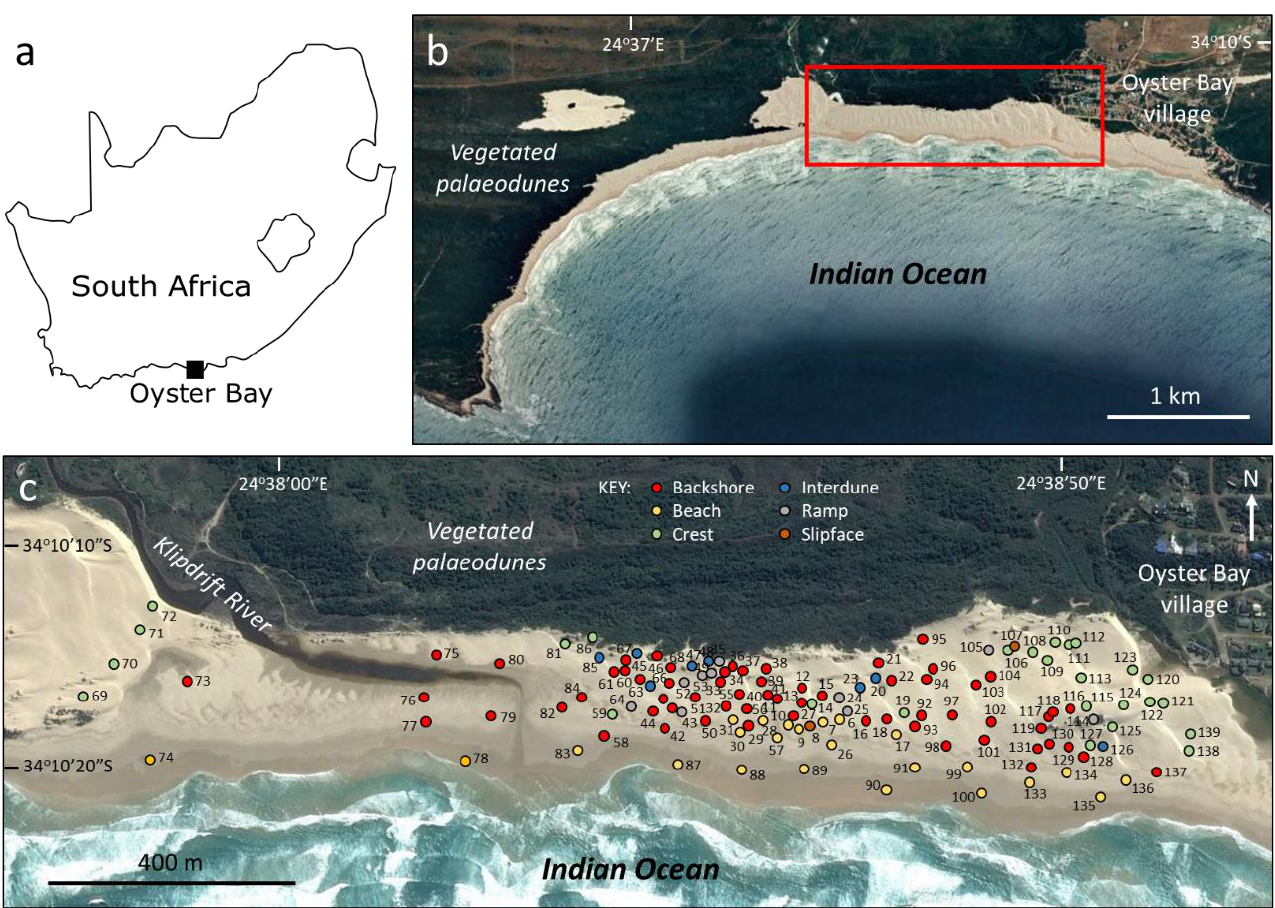
Figure 1. ( a ) Location of the study area at Oyster Bay, Eastern Cape, South Africa; ( b ) large-scale geomorphic setting of Oyster Bay with the sampling region (panel c ) shown in the red box; ( c ) distribution of sediment sampling points 006 – 139 (background image in ( c ) from Google Earth, image date 25 August 2013, which is the latest available image before the sampling period).